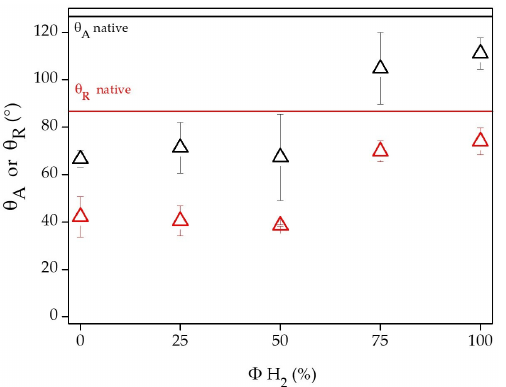
Figure 5. Variation of advancing and receding WCAs of PCL scaffolds treated with Ar, Ar/H 2 , or H 2 as a function of the feed composition: black triangles represent θ A ; red triangles represent θ R ; black continuous line represents θ A for native scaffold (129 ± 3°); red continuous line represents θ R for native scaffold (88 ± 1°).